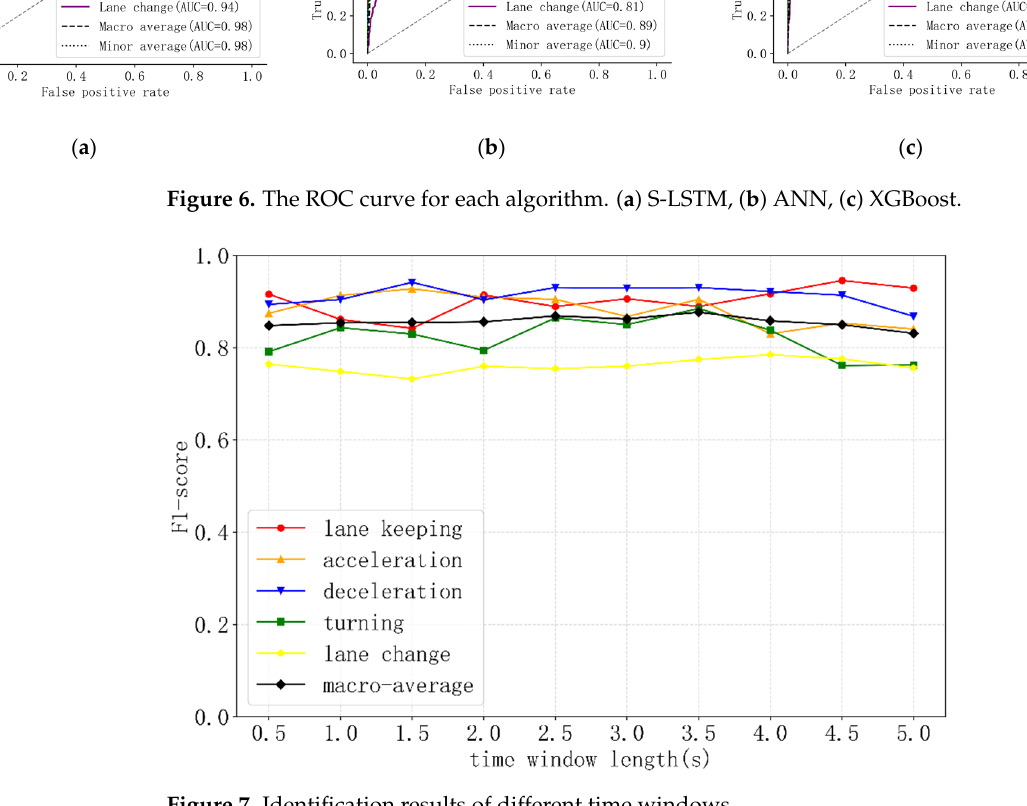
Figure 8. Confusion matrix of driving behavior identification. 5. Conclusions In this paper, a non-intrusive method was used to collect high-precision vehicle kin- ematic data and high-definition video data through an online car-hailing naturalistic driv- ing test in Nanjing, which ensured the capture of rich information on driving behaviors with no interference to driving, improving the identification of driving behaviors, and providing theoretical support for analyzing driving behavior using multi-source data.